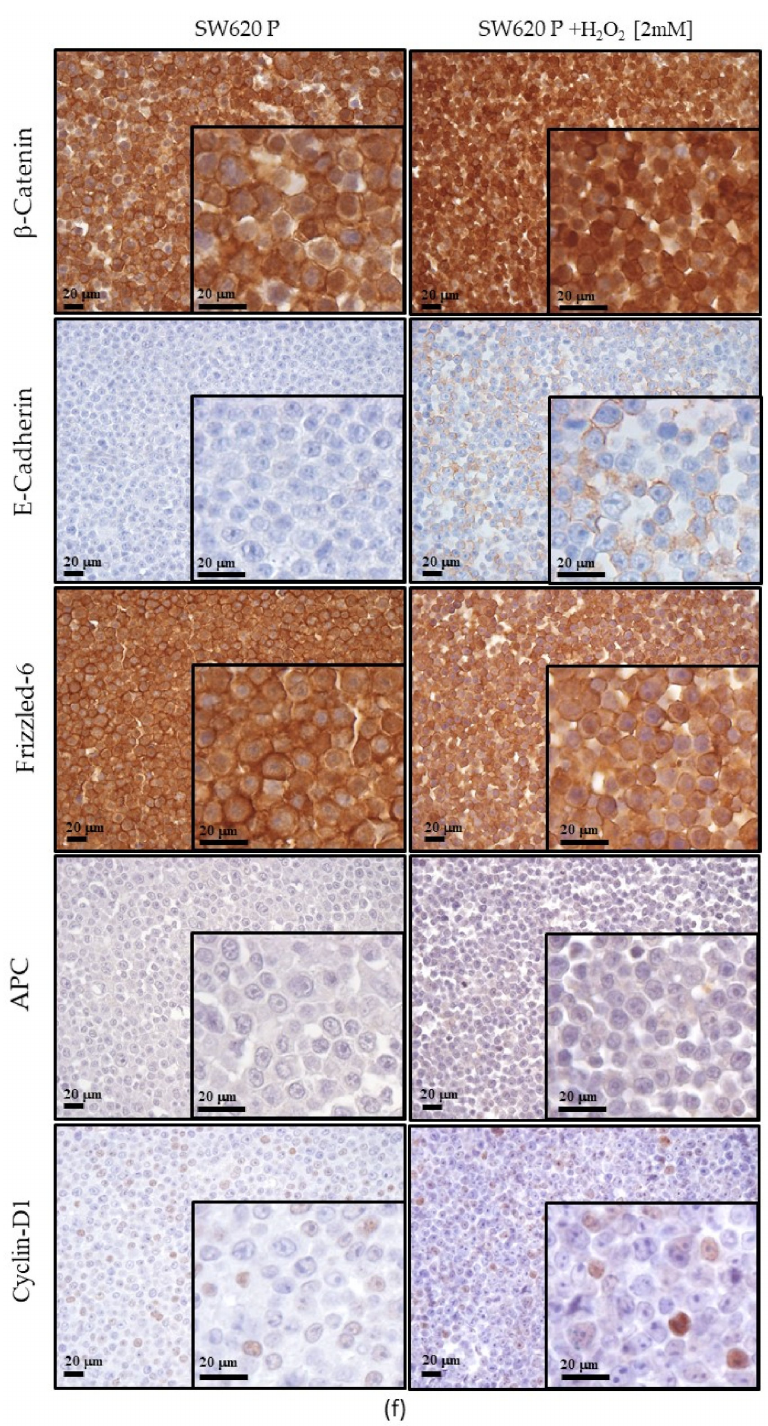
Figure 7. Expression of Wnt pathway components observed by ICC of cell block sections. In quiescent conditions HCT116 ( a ), SW480 ( c ) and SW620 ( e ) cells, in proliferative conditions HCT116 ( b ), SW480 ( d ) and SW620 ( f ) cells. Scale bars = 20 µ m. In metastatic SW620 cells cultured under homeostatic conditions, untreated cells did not show any immunoreactivity related to the investigated Wnt/ β -Catenin signaling molecules. Otherwise, the cytoplasmic expression of E-cadherin, membranous expression of FZD6, membranous and nuclear expression of β -Catenin and nuclear expression of cyclin D1were only observed in H 2 O 2 treated cells (Figure 7e). In proliferative SW620